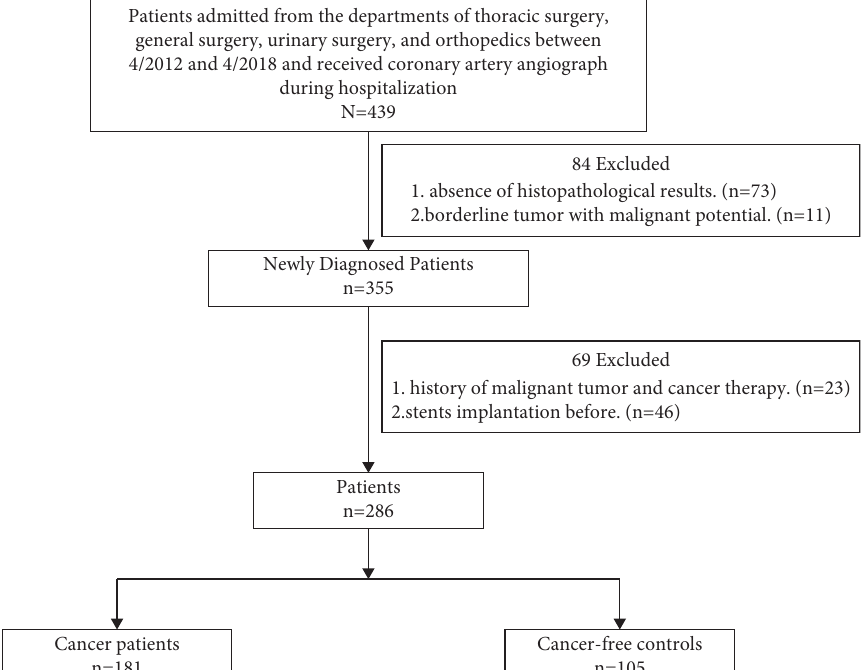
Figure 1: Patient inclusion and exclusion